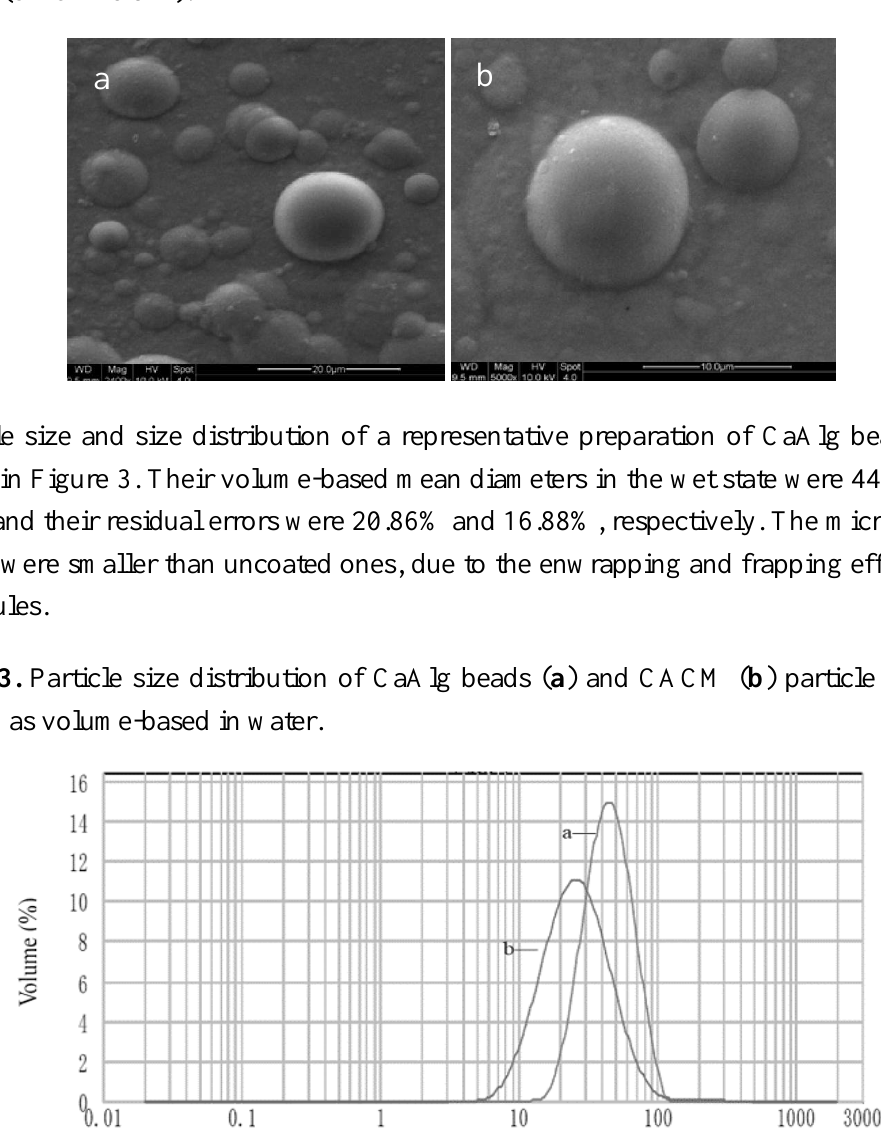
Figure 2. Scanning electron micrographs of calcium alginate-chitosan microspheres - glucose oxidase (CACM-GOX).